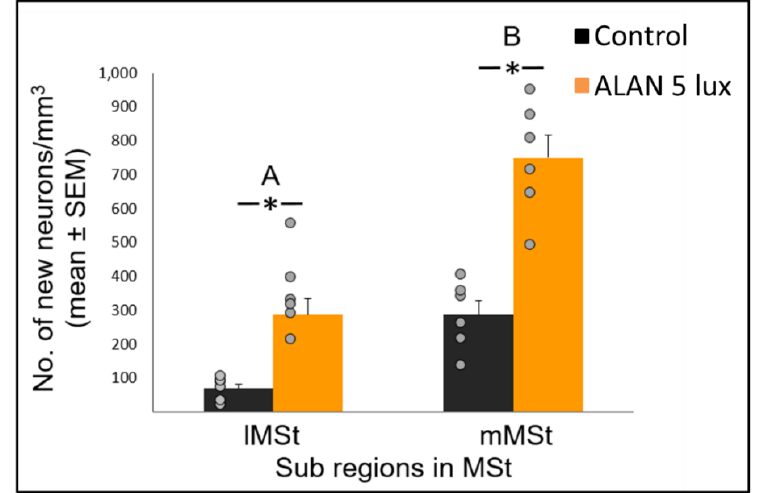
Figure 2. New neuronal recruitment (number of new neurons per mm 3 ; mean ± SE) in the lateral (lMSt) and medial (mMSt) sub-regions of the medial striatum (MSt). Control birds were exposed to dark night whereas the experimental group was exposed to 5 lux ALAN. Grey dots indicate the individual data points, * indicates a significant difference between groups ( p < 0.05), and different letters indicate significant difference between MSt sub-regions ( N = 6 birds/group).